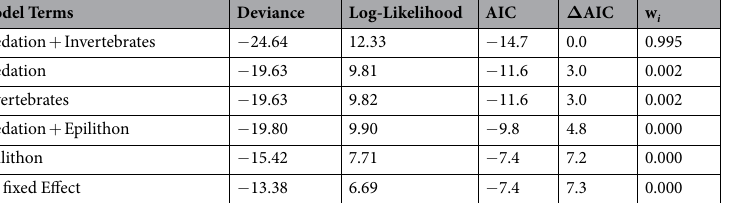
Table 2. AIC score-based comparison of mixed models for the average trophic position of guppies from one High Predation (HP) and one Low Predation (LP) site across five different rivers. “Predation” represents the presence or absence of effective piscivores in the site where guppies were sampled (i.e., HP vs. LP). “Epilithon” is the average AFDM from pools at a site, and “invertebrates” is the biomass of invertebrates at that site. All models include the river as a random effect to account for differences among rivers.